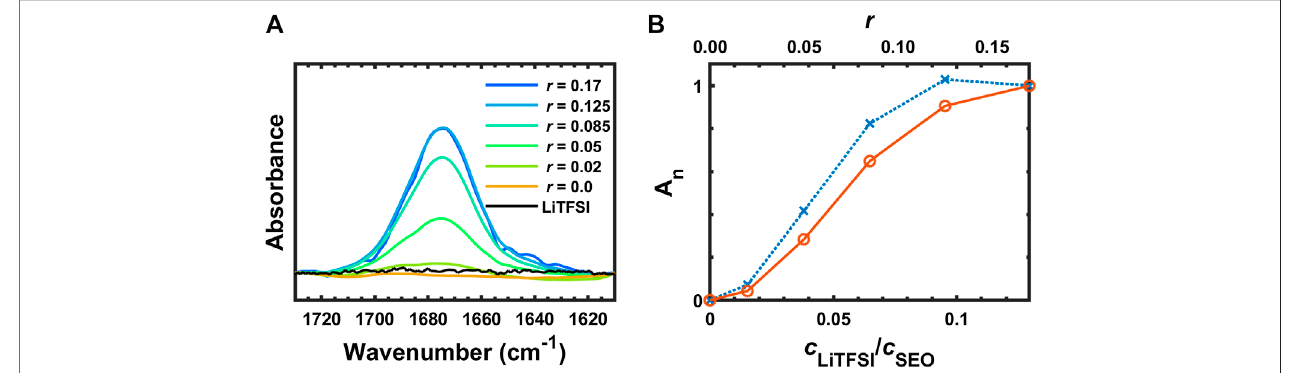
FIGURE 8 | (A) FTIR-ATR spectra of SEO, SEO/LiTFSI, and LiTFSI from 1,715 to 1,615 cm − 1 , and (B) normalized integration of (A) ( ···×··· A n ) and normalized, calibrated absorbance ( ─ ○ ─ A c , n ).